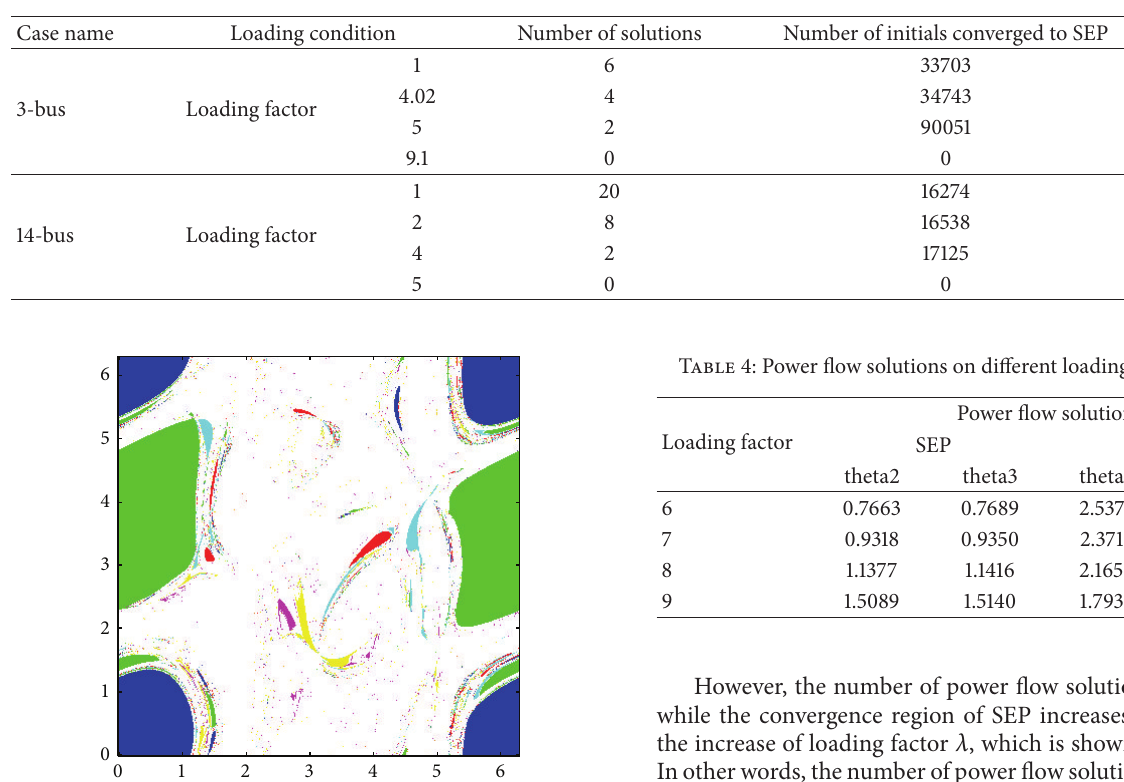
Table 3: Number of power flow solutions and fractal properties at different loading conditions.